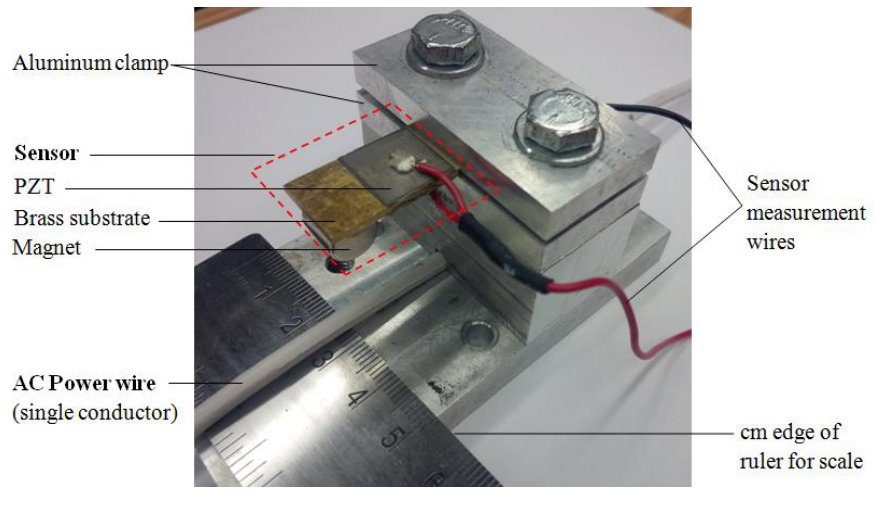
Figure 12. Current sensor prototype testing.